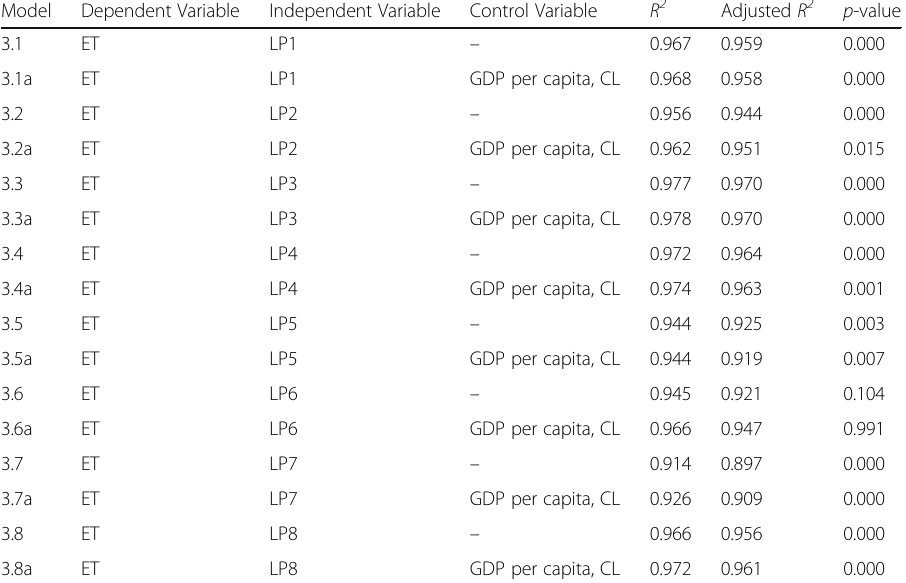
Table 4 Regression Results of Hypothesis